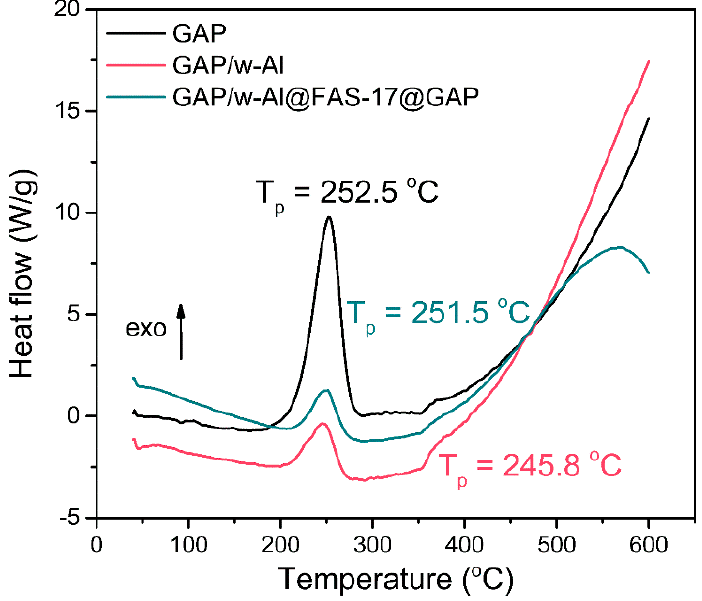
Figure 5. DSC curves of GAP, GAP/w-Al and GAP/w-Al@FAS-17@GAP.